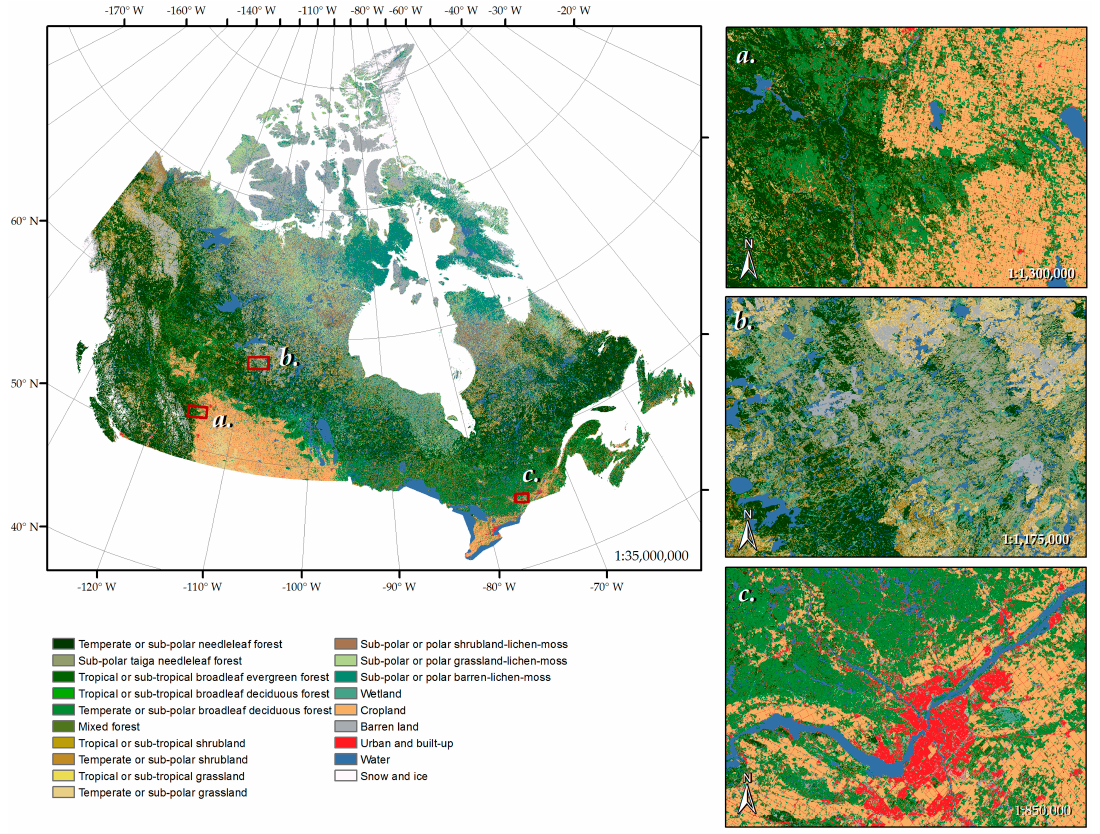
Figure 5. Land cover of Canada at 30 m spatial resolution for 2010.